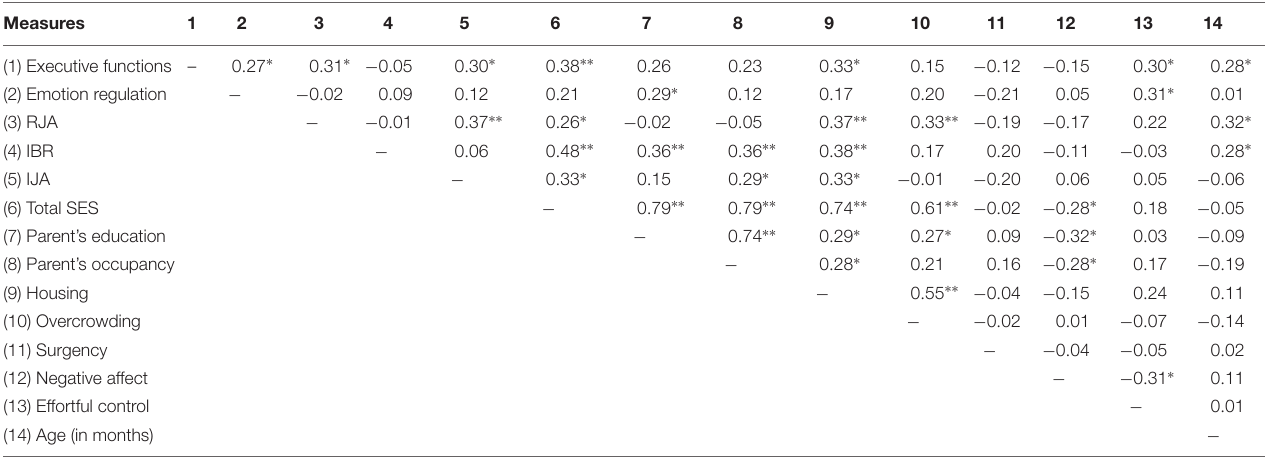
TABLE 5 | Correlations among composite measures of regulatory abilities, joint attention skills, SES subdimensions, temperamental styles, and age.